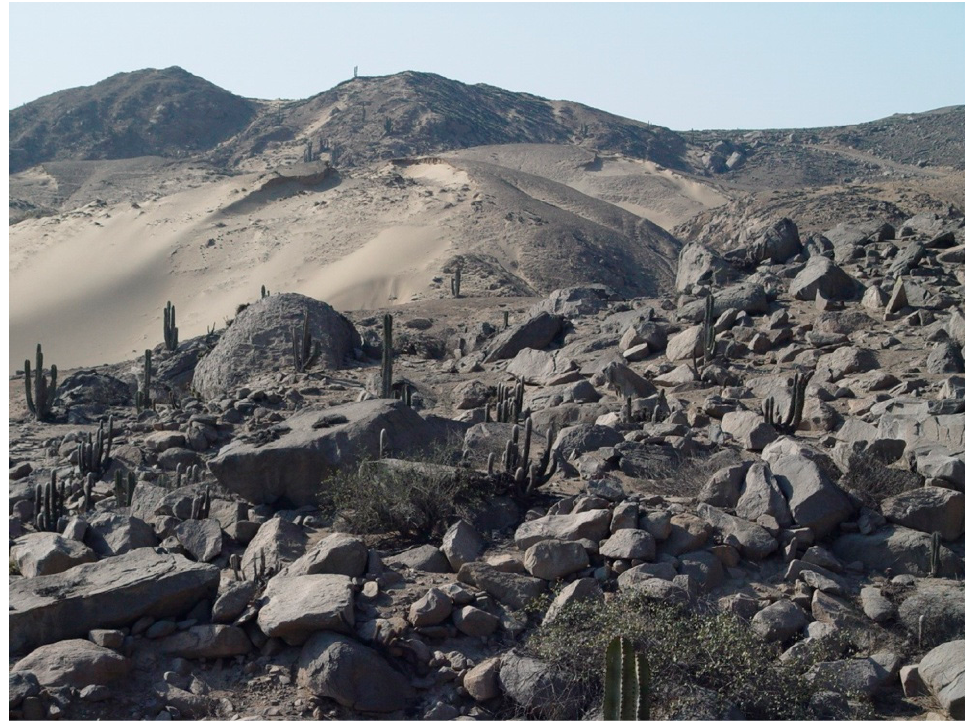
Figure 6. Type locality of Meromacrus cactorum sp. nov. (Cerro Campana, Trujillo, Peru) with Espostoa melanostele cacti, where larvae of this new Meromacrus species were found (Photo: Eduardo Galante). 3.1.2. Meromacrus yucatense sp.